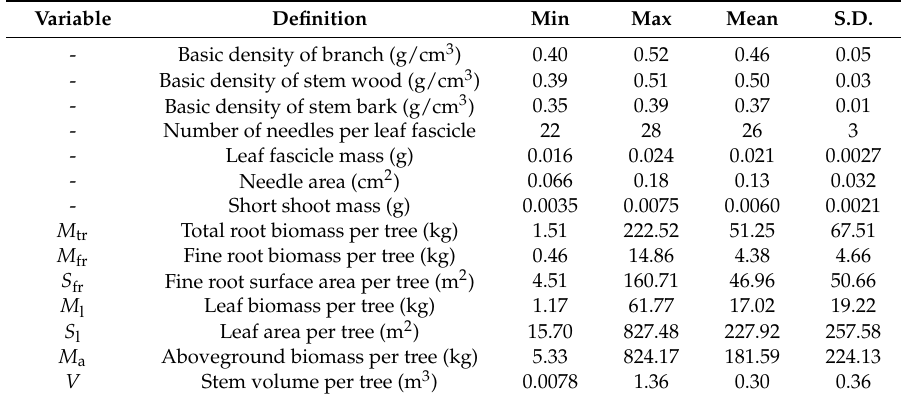
Table 1. Descriptive statistics of sub-samples and sampled trees for developing biomass